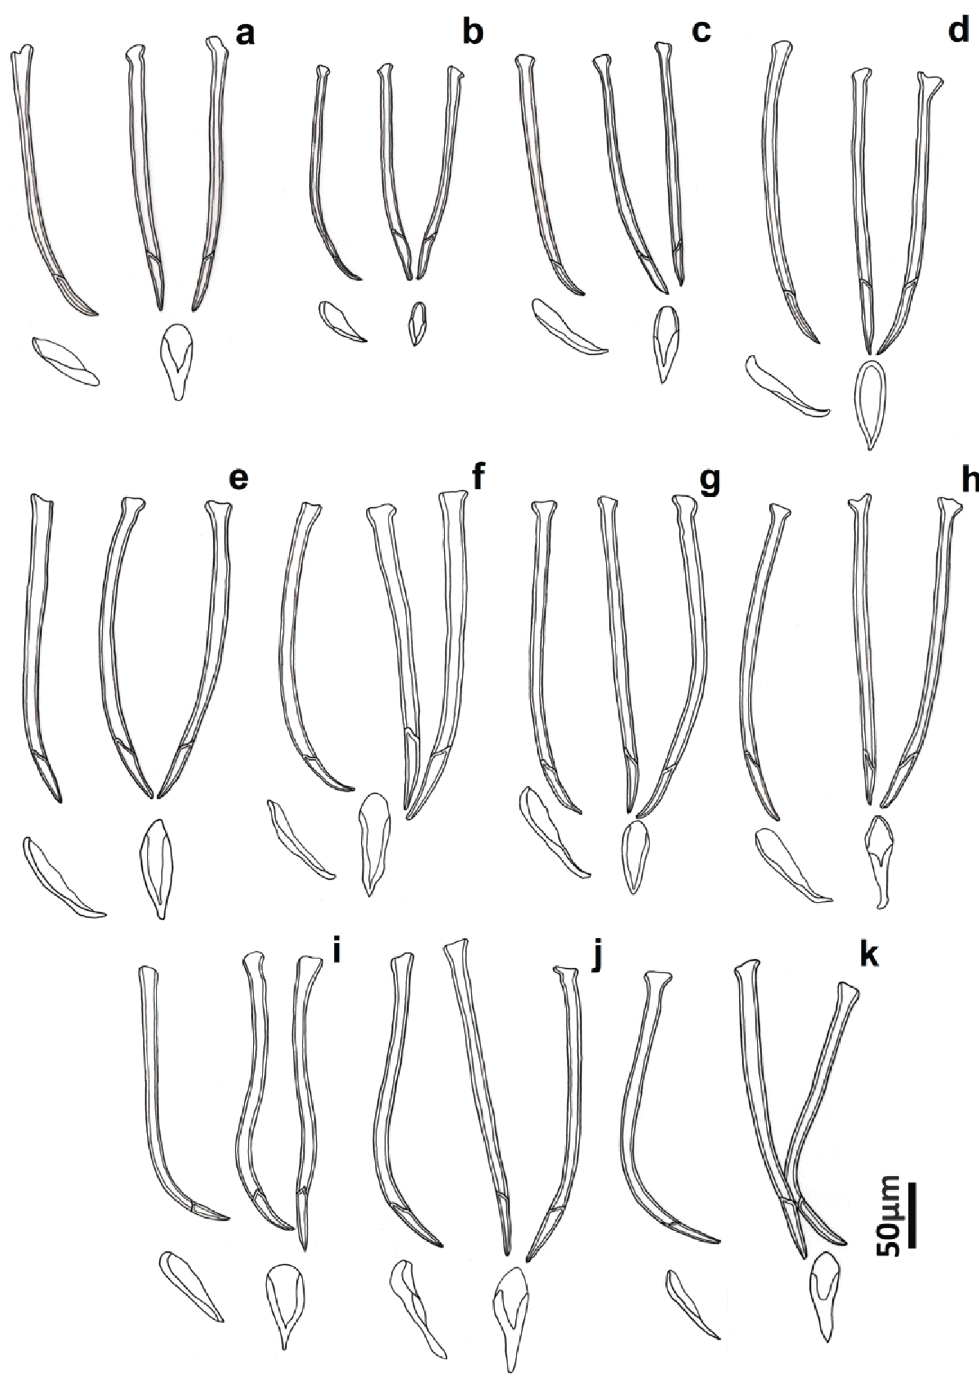
Figure 3 - Morphology of the spicules and the gubernaculum of A. hylambatis from different amphibian hosts and localities in Argentina. Spicules and gubernaculum are shown in lateral view (to the left of each figure) and in ventral view (to the right of each figure). (a) L. bufonius from Corrientes. (b) L. bufonius from las lomitas. (c) L. bufonius from Taco Pozo. (d) D. muelleri from las lomitas. (e) R. major from Concepción del Bermejo. (f) R. major from Ingeniero Juárez. (g) R. major from las lomitas. (h) R. major from Taco Pozo. (i) R. arenarum from la Plata. (j) R. arenarum from San Juan. (k) P. santafecinus from